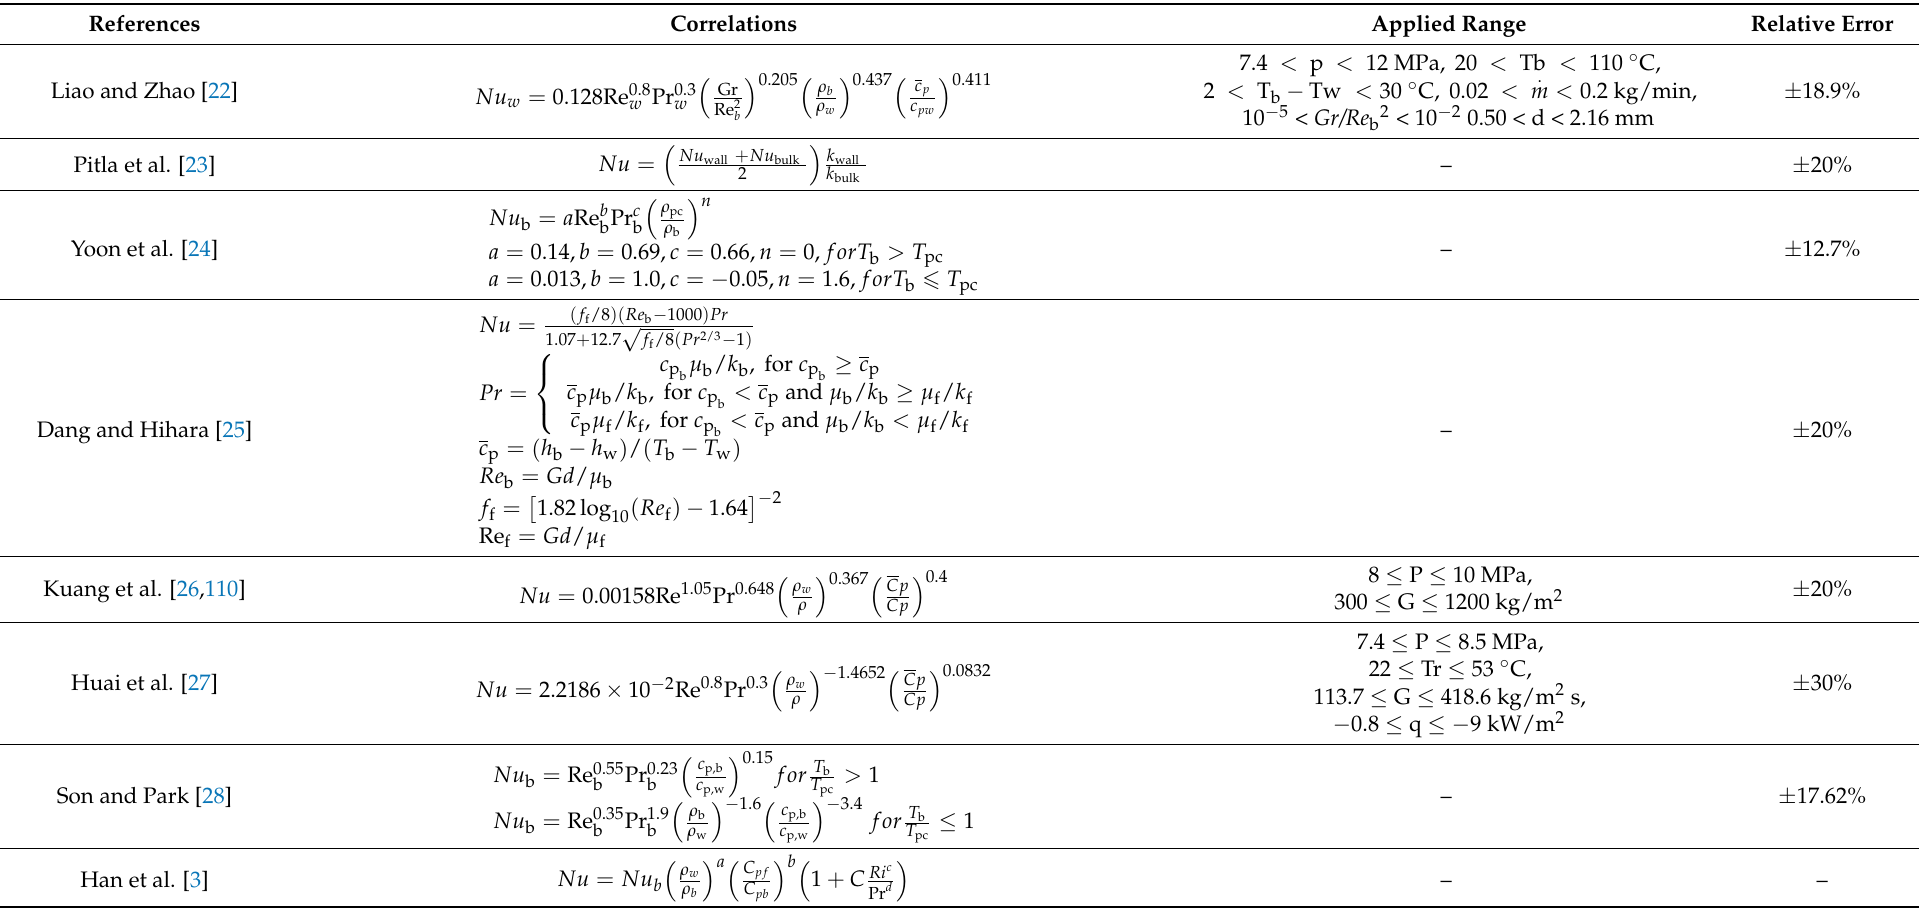
Table 3. Heat transfer correlations under SCO 2 cooling